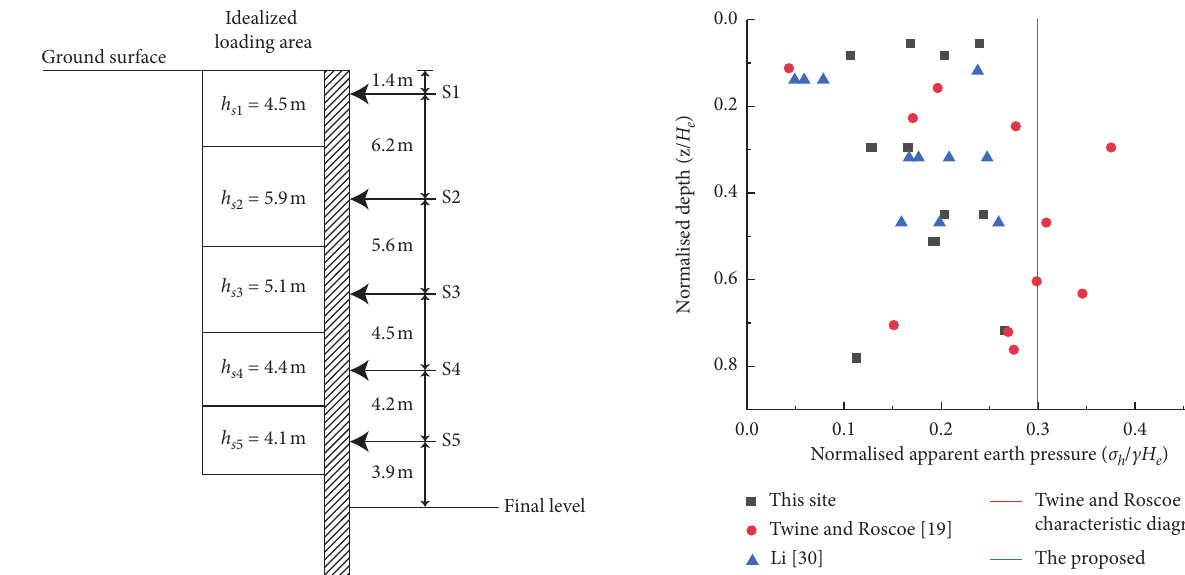
Figure 19: Normalized apparent earth pressure versus normalized depth for stiff walls in this region and other